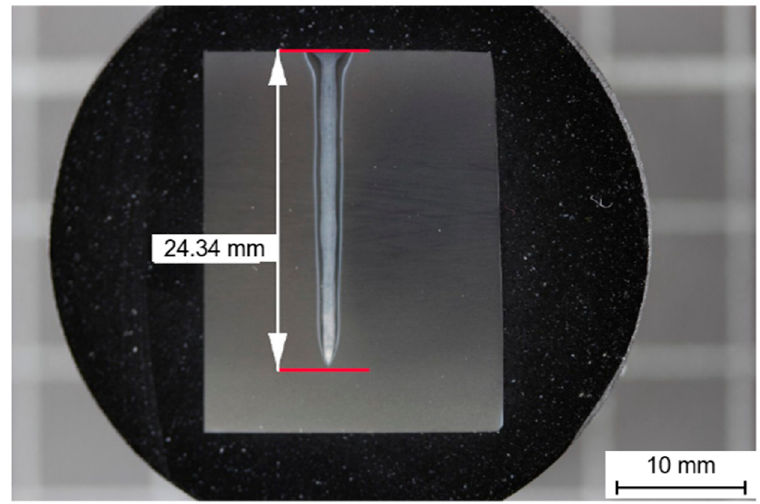
Figure 4. Artificially induced material defect.